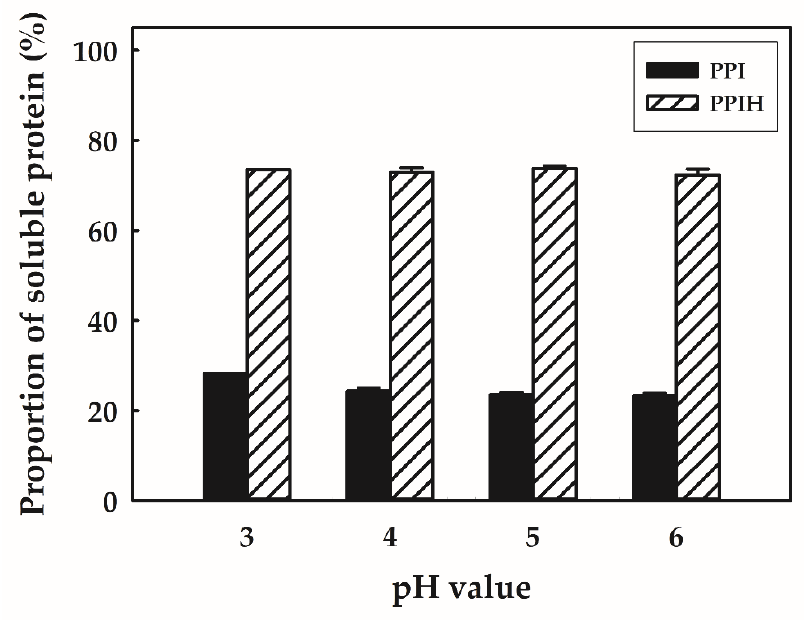
Figure 1. Effect of pH on the solubility of potato protein isolate (PPI) and PPI hydrolysate (PPIH). Each value is represented as the mean ±SD.